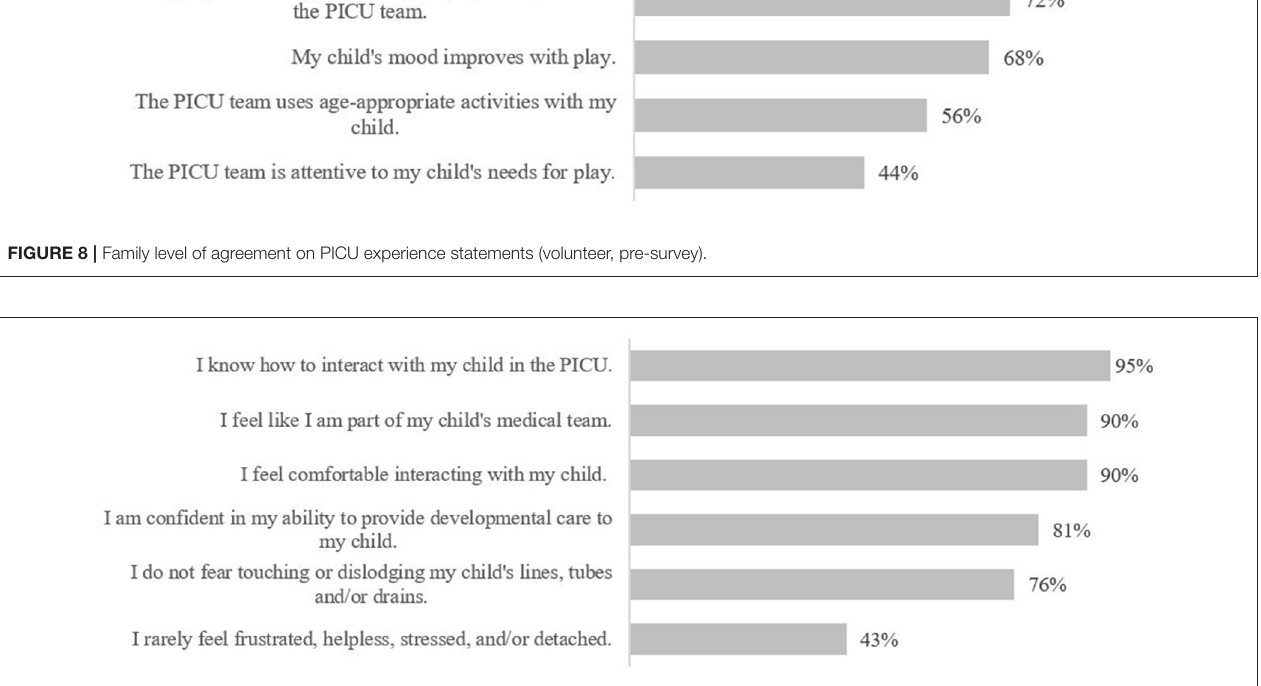
FIGURE 9 | Family level of agreement in PICU experience statements (peer mentor,